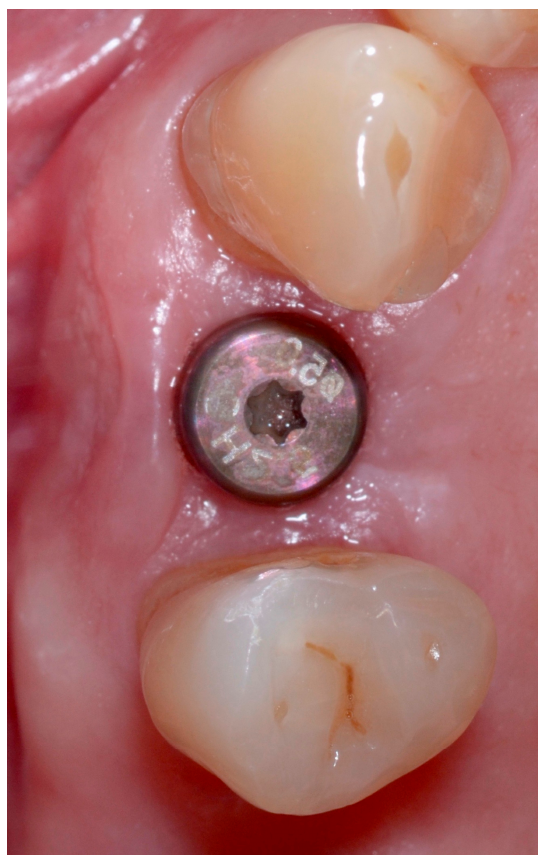
Figure 9. Clinical view at suture removal.